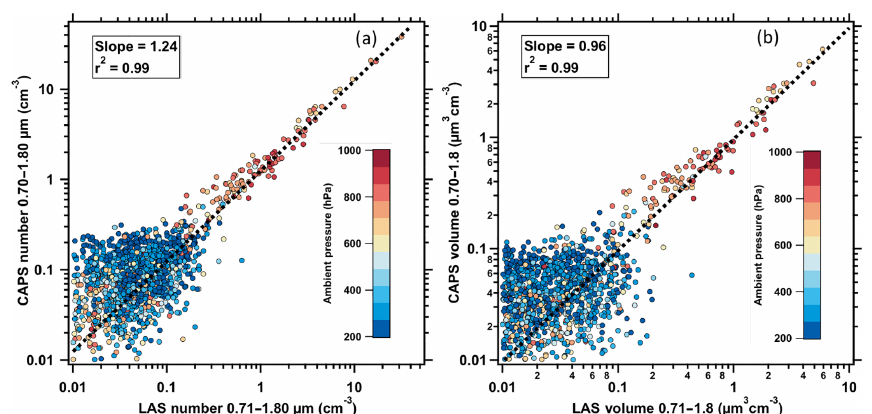
Figure 10. (a) The 1min average CAPS number concentrations for diameters from ∼ 0 . 7 to 1.80µm plotted against the same parameter from the LAS instrument for periods of flight during ATom-1 when RH with respect to liquid water was <40%. (b) As in (a) , but for particle volume. Lines and slopes are from two-sided least-squares linear regression forced through zero. Values of r 2 are from a one-sided linear least-squares regression.